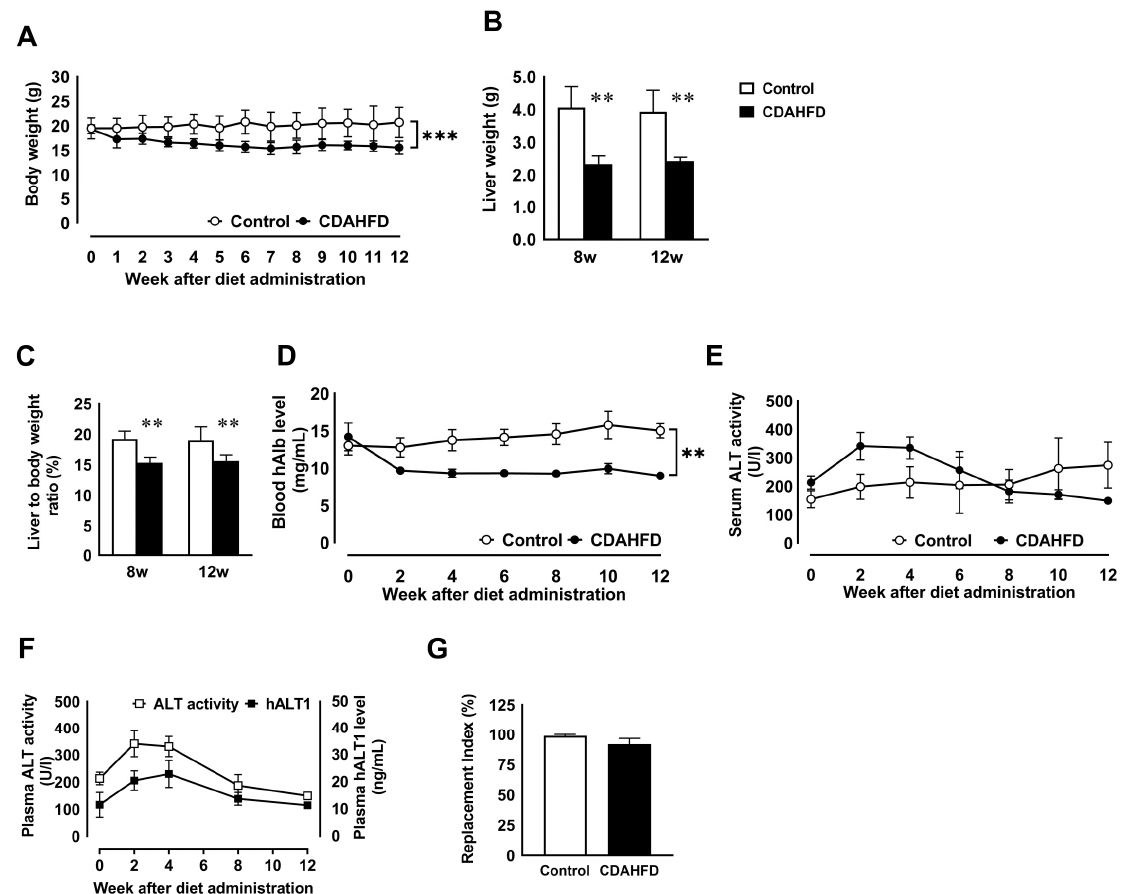
Figure 1. Changes in the physical and biochemical profiles of human chimeric mice after CDAHFD feeding. Time-course changes in the body weight of the CDAHFD (closed circle) or control (open circle) groups ( A ). The liver weight ( B ) and ratio of liver weight to body weight ( C ) of the control and CDAHFD-fed mice at week 8 or 12. Open and closed bars show the control and CDAHFD-fed mice, respectively. Time-course changes in the level of blood human albumin ( D ) and plasma ALT activity ( E ) of the CDAHFD or control group. The time-course changes in plasma ALT activity and the human-specific ALT1 concentration in the plasma of the CDAHFD group ( F ). Replacement index of the h-heps in chimeric mouse livers ( G ). Results are represented as the mean ± standard deviation ( n = 3 or 4 per group). ** Significant difference from the control group ( p < 0.01). *** Significant difference from the control group ( p < 0.001). CDAHFD: choline-deficient, L-amino-acid-defined, high-fat diet, ALT: alanine aminotransferase.